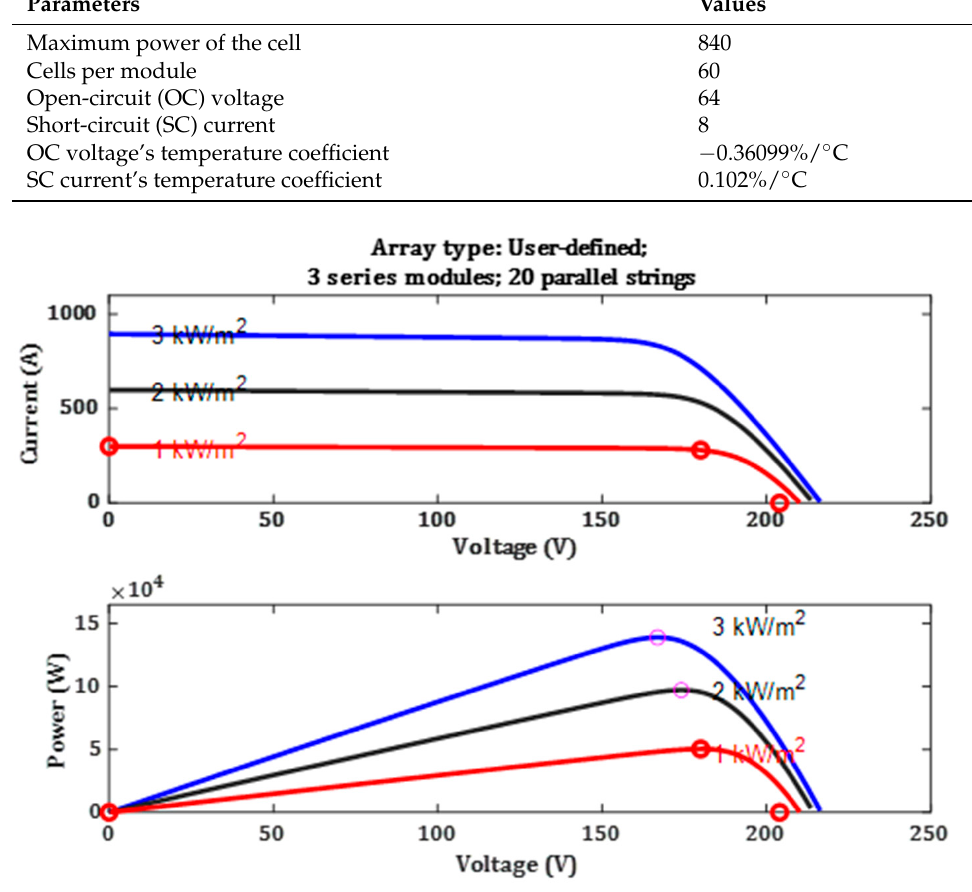
Figure 3. Characteristics of PV array [10].